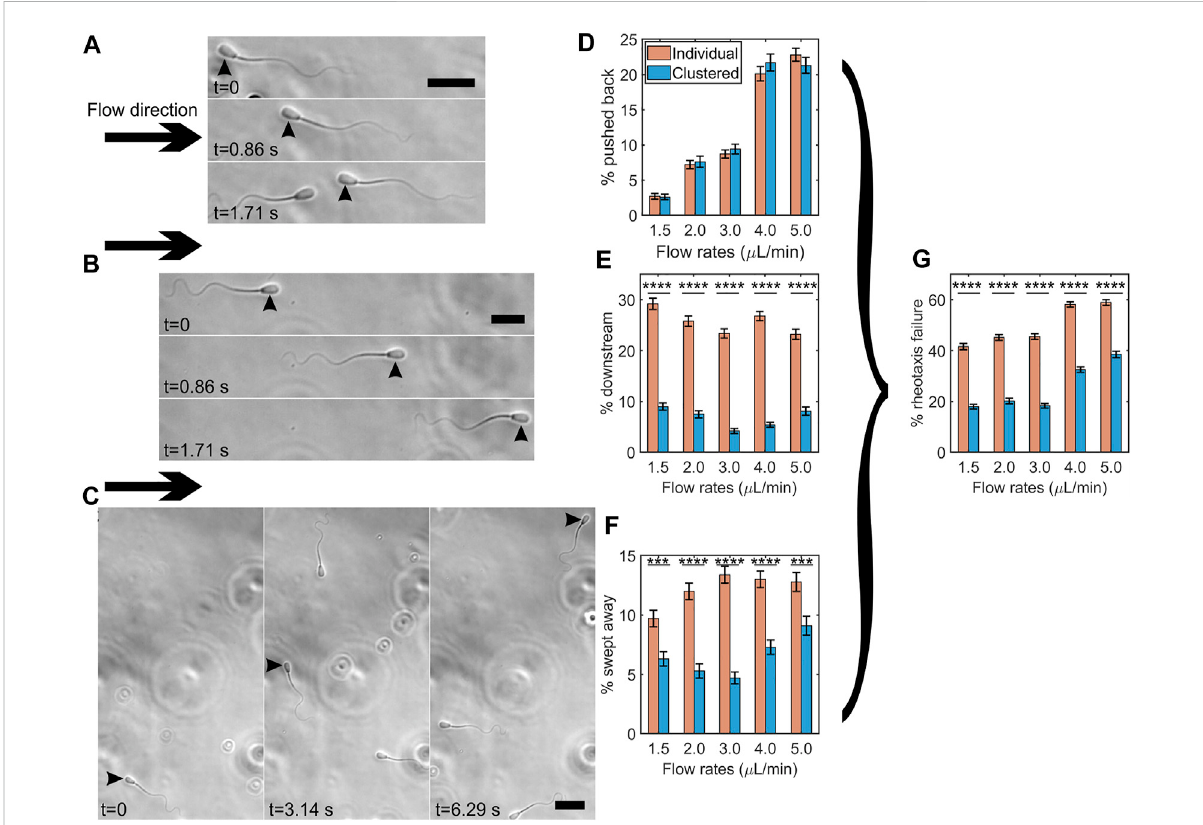
Clustering protected sperm from being swept downstream by a strong fl ow. Time lapse montage of bovine sperm being pushed back (A) , swimming downstream (B) , and being swept away (C) under a fl ow of 5.0 μ l/min. Flow direction is shown by arrows and the sperm showing the speci fi c behavior is indicated by arrowheads. Scale bar = 25 μ m. Percentages of individual vs. clustered sperm being pushed back (D) , swimming downstream (E) ,andbeingsweptawayunderdifferent fl owrates (F) .Percentages ofindividual vs.clustered sperm undergoingrheotaxis failure under different fl ow rates (G) . The error bars represent the standard error of the mean (SEM, N ≈ 3,200 – 4,300 cells per bar), *** : p < 0.001, and **** : p < 0.0001. ( p = 0.91, 0.64, 0.42, 0.21, and 0.30 for 1.5, 2.0, 3.0, 4.0, and 5.0 μ l/min respectively for the % of pushed-back sperm by two proportion